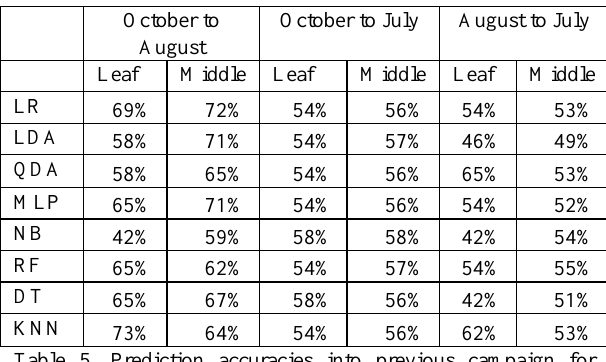
Table 5. Prediction accuracies into previous campaign for Loureiro Overall prediction accuracies to previous campaign in Loureiro caste were low. Highest scores were achieved in prediction from October to August, by LR, LDA, MLP and KNN, with about 70%. Prediction from October to July and from August to July did not surpass